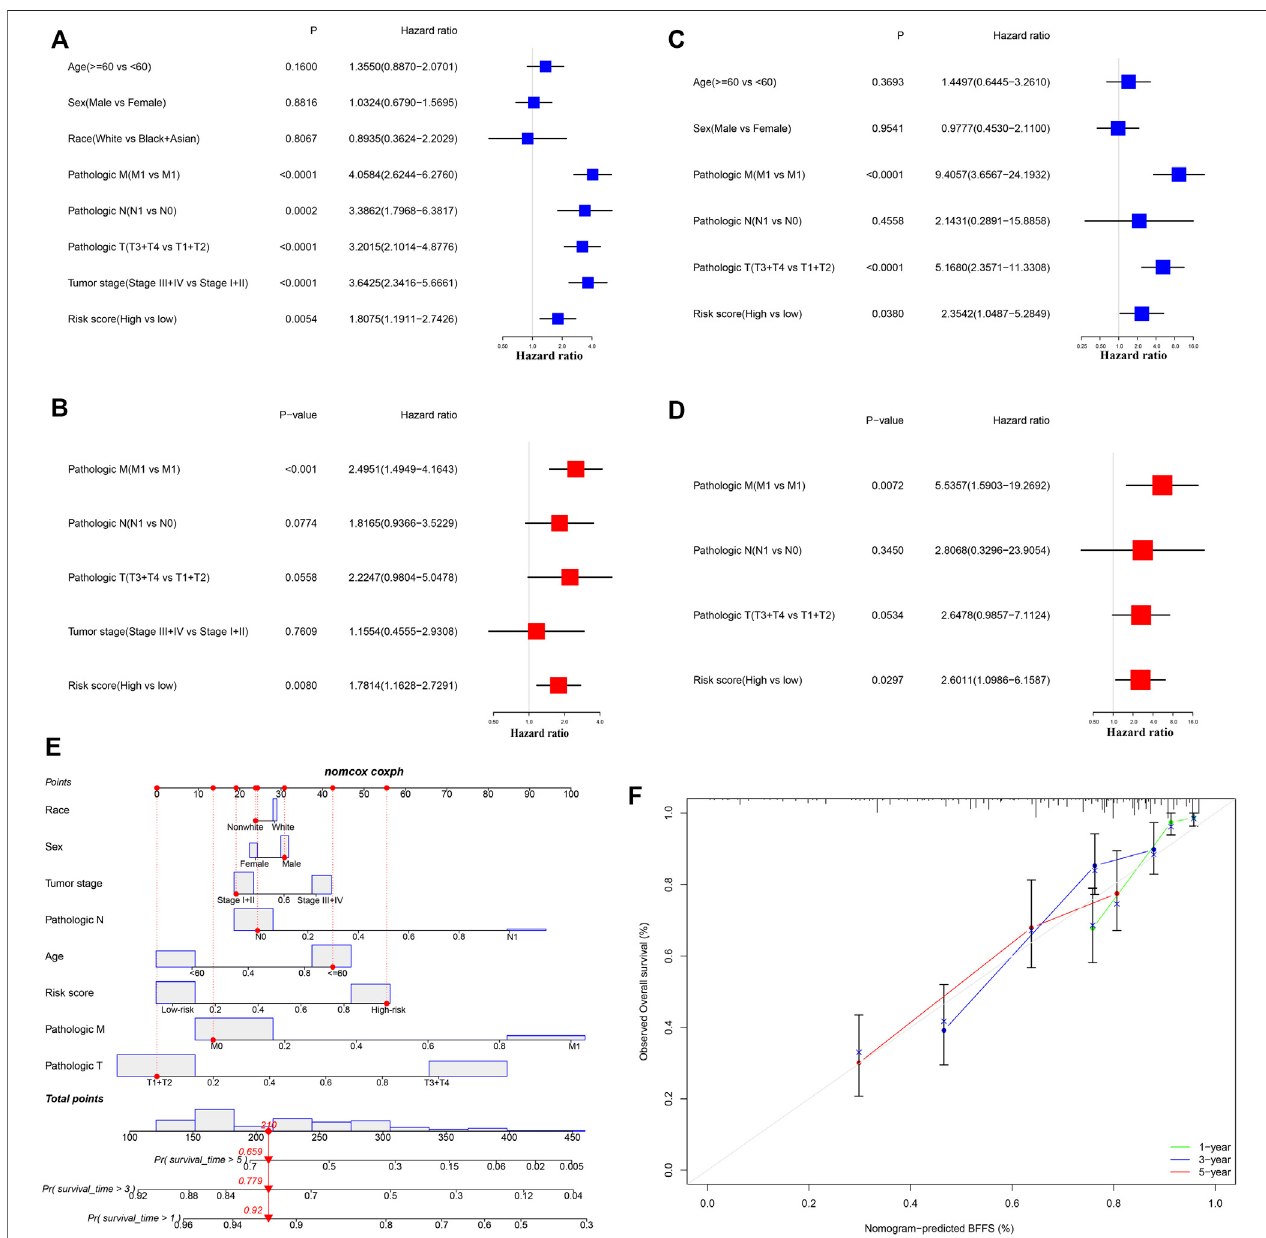
FIGURE 4 | Cox regression analyses. (A,B) Univariate and multivariate Cox regression analyses of patients in TCGA. (C,D) Univariate and multivariate Cox regression analyses in ICGC. (E) Nomogram-based gene signatures for prediction of 1-, 3- and 5-year OS. (F) Calibration plots for agreement tests between predicted and actual